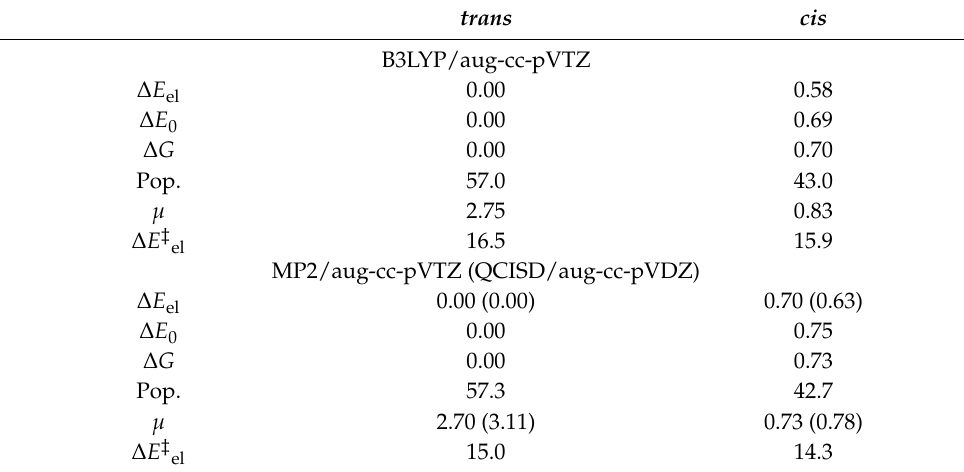
Table 1. Relative energies ( ∆ E el , ∆ E 0 , and ∆ G ), equilibrium populations (Pop.) at 298.15 K and dipole moments ( µ /D) of the cis and trans conformers of m FP, and energy barriers for their interconversion ( ∆ E ‡ el ), calculated at different levels of theory a